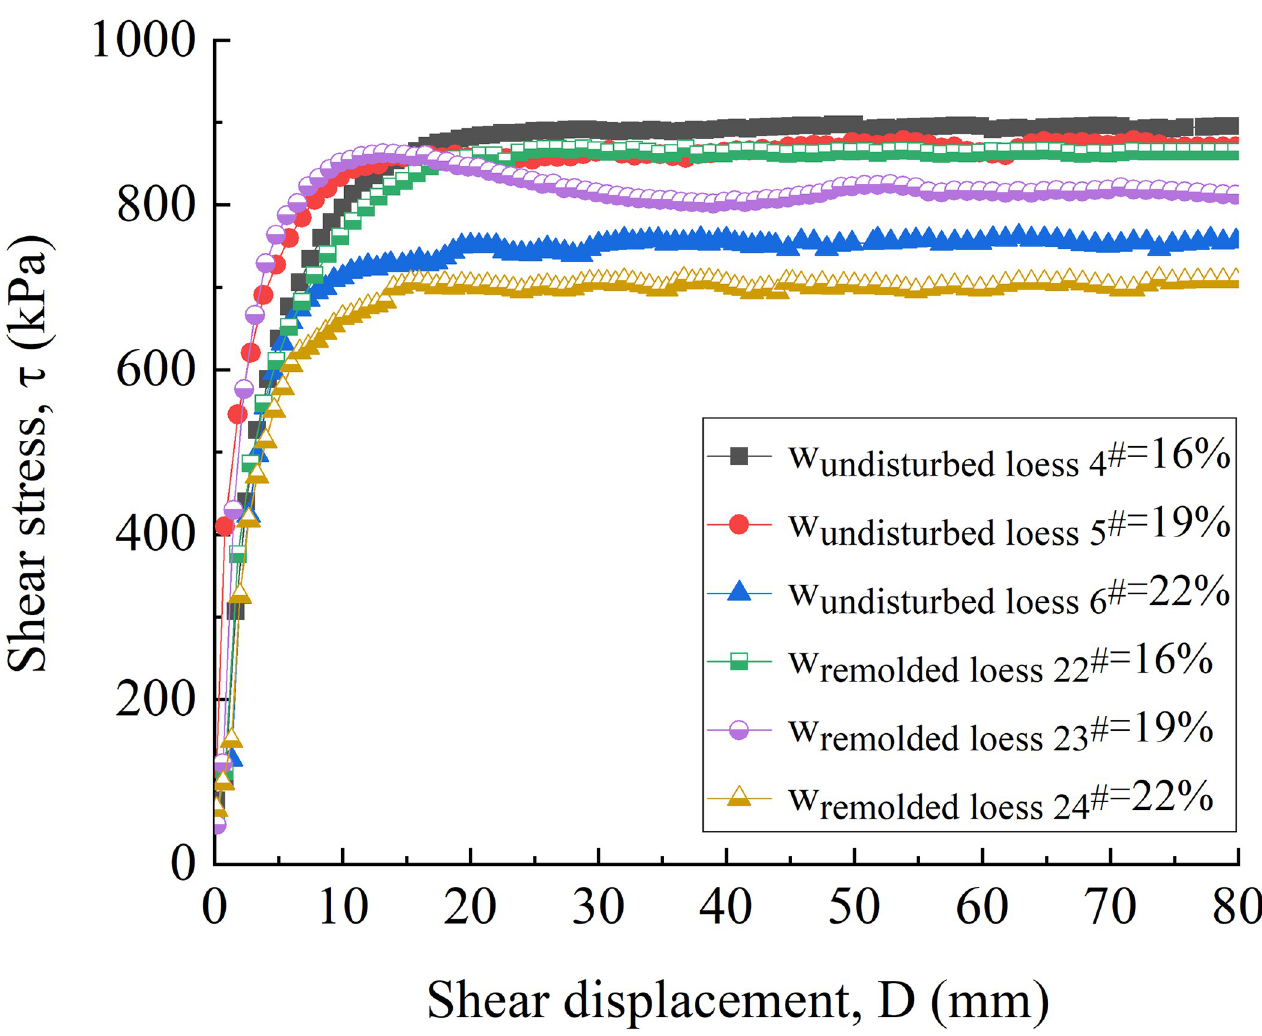
Fig 12. Shear stress-shear displacement curve of 4 # - 6 # undisturbed and 22 # - 24 # remolded loess specimens under different water content.